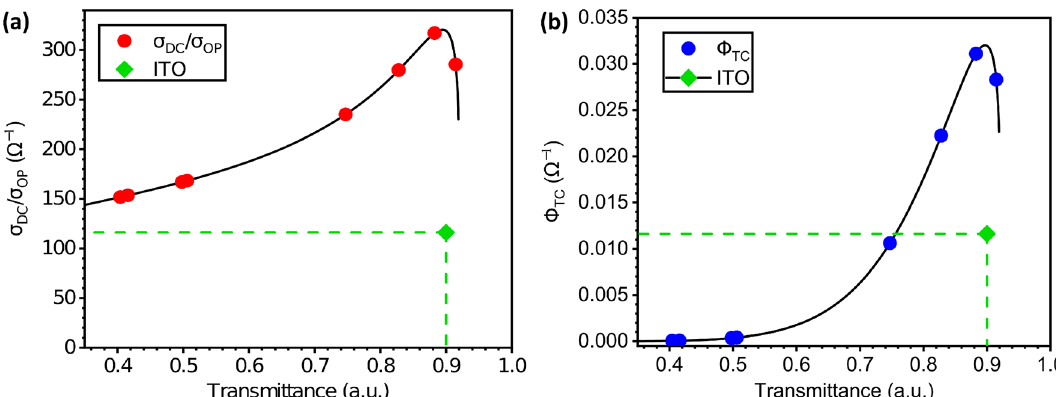
Figure 6. Figures of merit for transparent conductive electrodes ( a ) σ DC /σ OP and ( b ) (cid:31) TC . Both figures of merit conclude that the sample with 2 layers offers the best balance between transparency (T = 88.27%) and sheet resistance (R sh = 9.81 �/ sq. ). The FoM values for ITO on glass are represented by the green diamond for